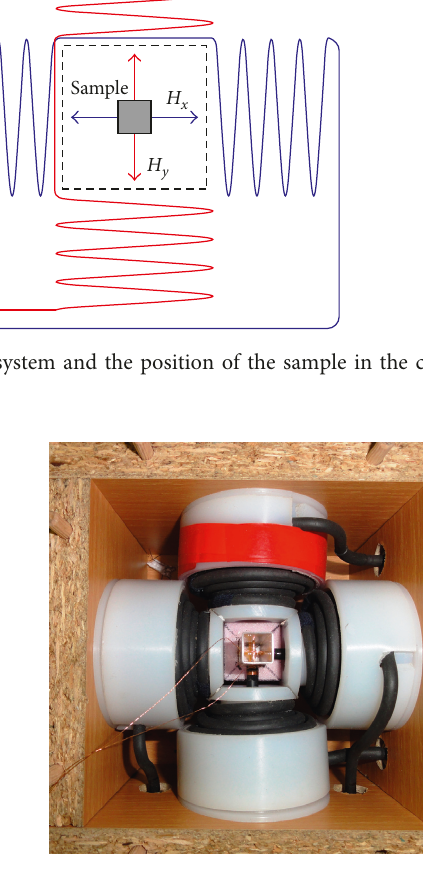
Figure 2: Actual measurement system in a 20 × 20 cm